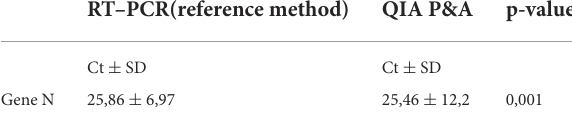
TABLE 4 Median CTs of Gene N by the reference method and QIA